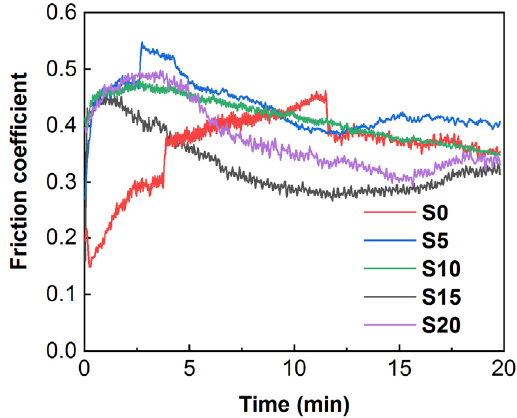
Figure 10. Variations in the friction coefficients of different samples during wear